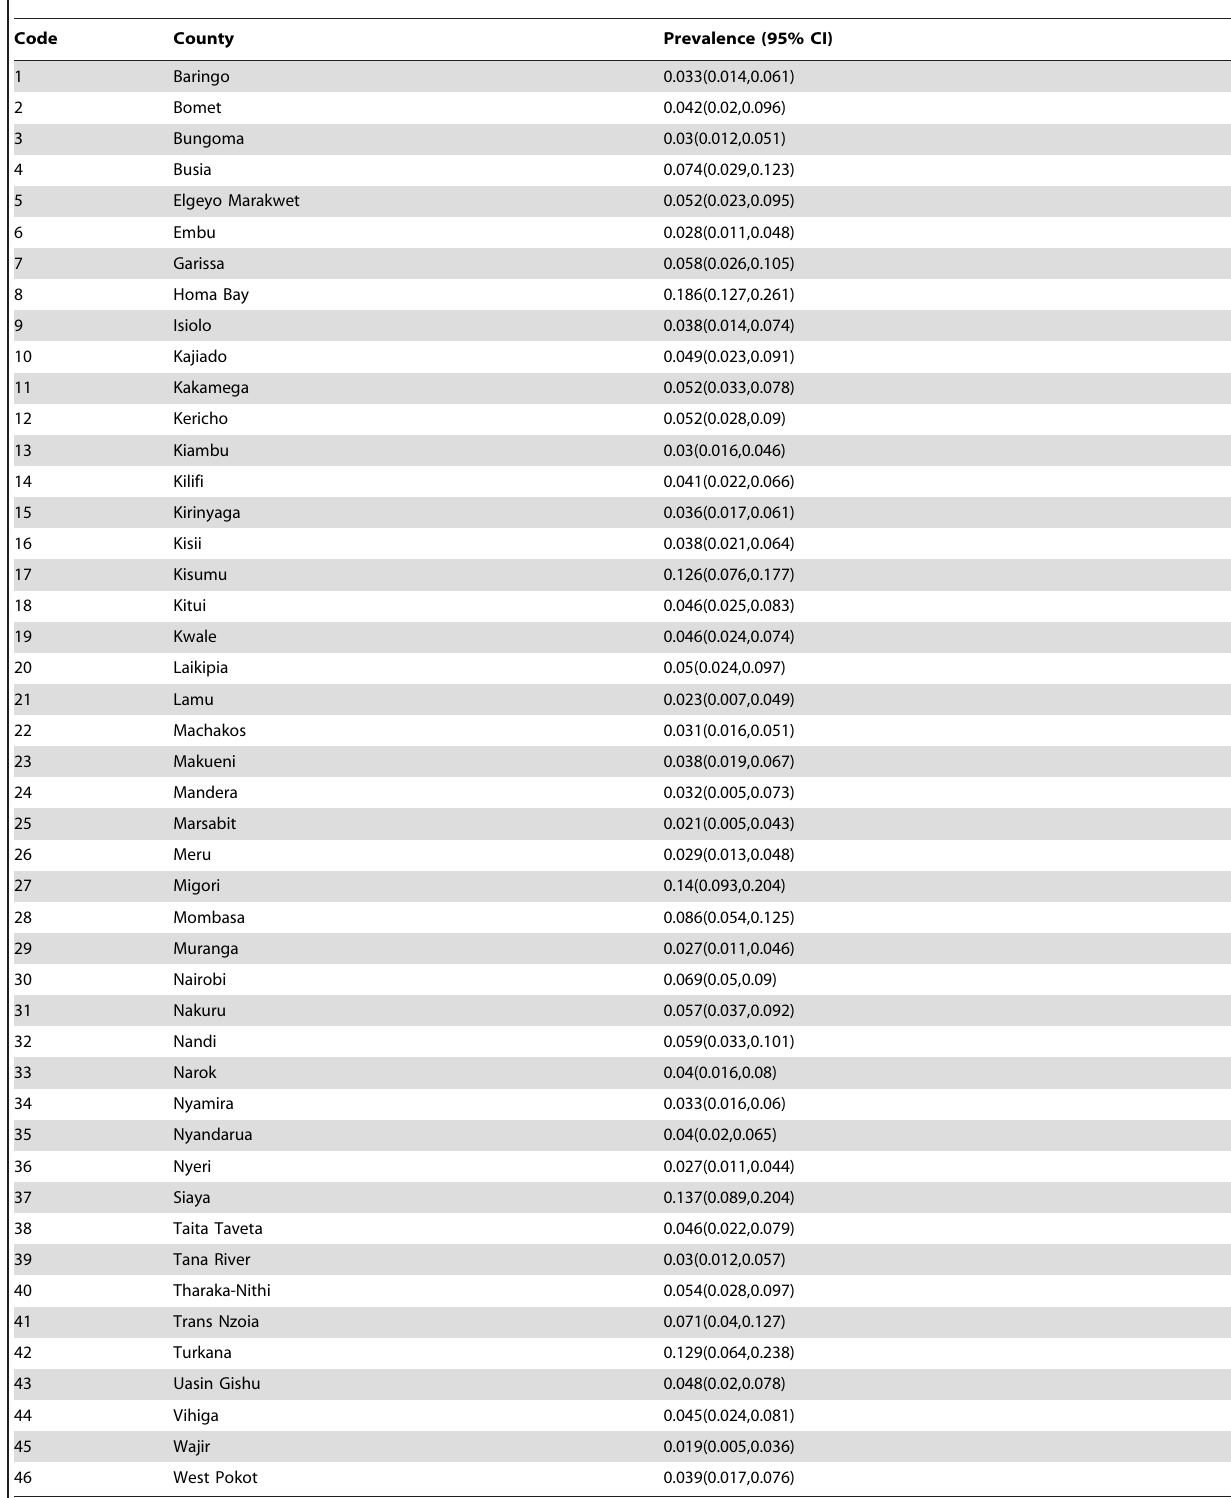
Table 5. Estimated HIV prevalence by county and corresponding 95% Credible